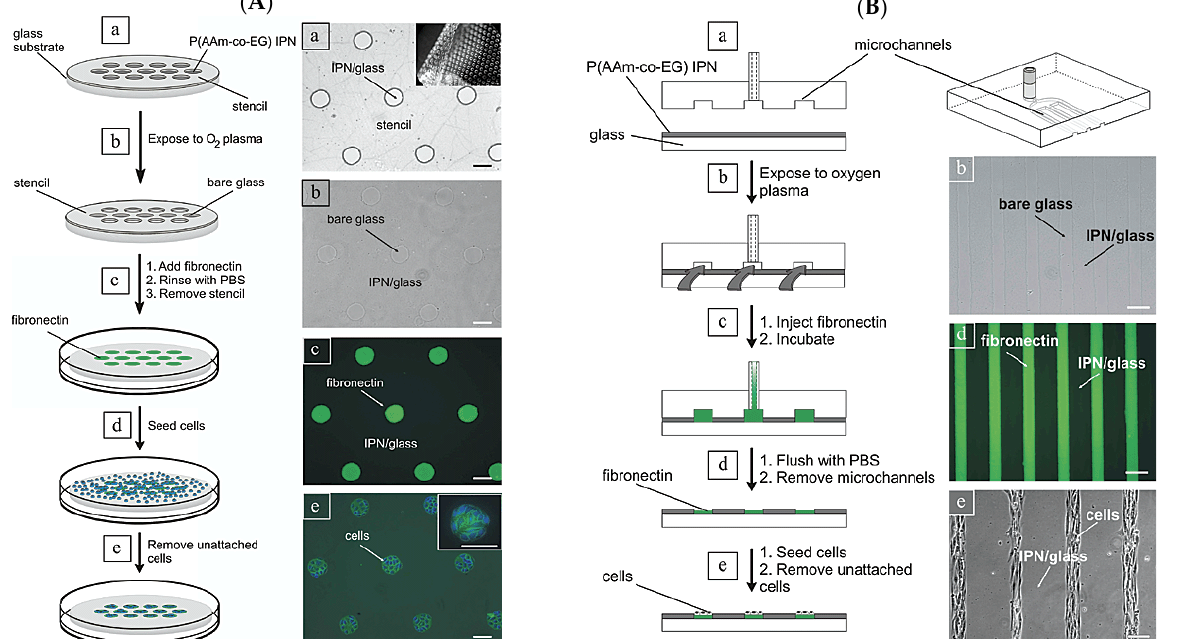
Figure 2. ( A ) Schematic illustration (left column) and demonstration (right column) of the procedure for cellular micropatterning based on the use of PDMS stencils. ( a ) The stencil is placed onto a glass substrate homogeneously grafted with the IPN. A picture of the stencil before (inset) and after application onto the surface is shown on the right. ( b ) The stencil serves as a mask for selective etching of the IPN in an oxygen plasma. The etching leaves islands of IPN-free glass surrounded by IPN (as shown in the corresponding phase-contrast image on the right). ( c ) Fluorescently tagged fibronectin (Fn) is adsorbed onto the plasma-etched islands of glass, and the stencil is removed. ( d ) The fibronectin/IPN-patterned substrate is incubated with a cell suspension. ( e ) Unattached cel ls are removed by exchanging the medium. The inset shows a fluorescence image of C2C12 myoblasts (blue) attached to the fibronectin islands (green). Scale bars are 100 µ m. ( B ) Schematic illustration (left column) and demonstration (right column) of the procedure for cellular micropatterning based on the use of PDMS microchannels. ( a ) The PDMS mold is placed onto a glass substrate, homogeneously grafted with the IPN. ( b ) The IPN is selectively removed after exposure of the surface to oxygen plasma, which leaves lines of IPN-free glass surrounded by IPN (see phase-contrast image on the right). ( c , d ) Fluorescently tagged fibronectin is injected into the microchannel network. After flushing with PBS, the microchannels are removed, leaving lines of fibronectin surrounded by IPN (see fluorescence image of the adsorbed fibronectin on the right). ( e ) The fibronectin/IPN-patterned substrate is incubated with a cell suspension and unattached cells are removed by exchanging the medium. Shown on the right is a phase-contrast image of C2C12 myoblasts attached to the lines of fibronectin. Scale bars are 100 µ m. Reprinted with permission from Ref. [13]. Copyright 2015,